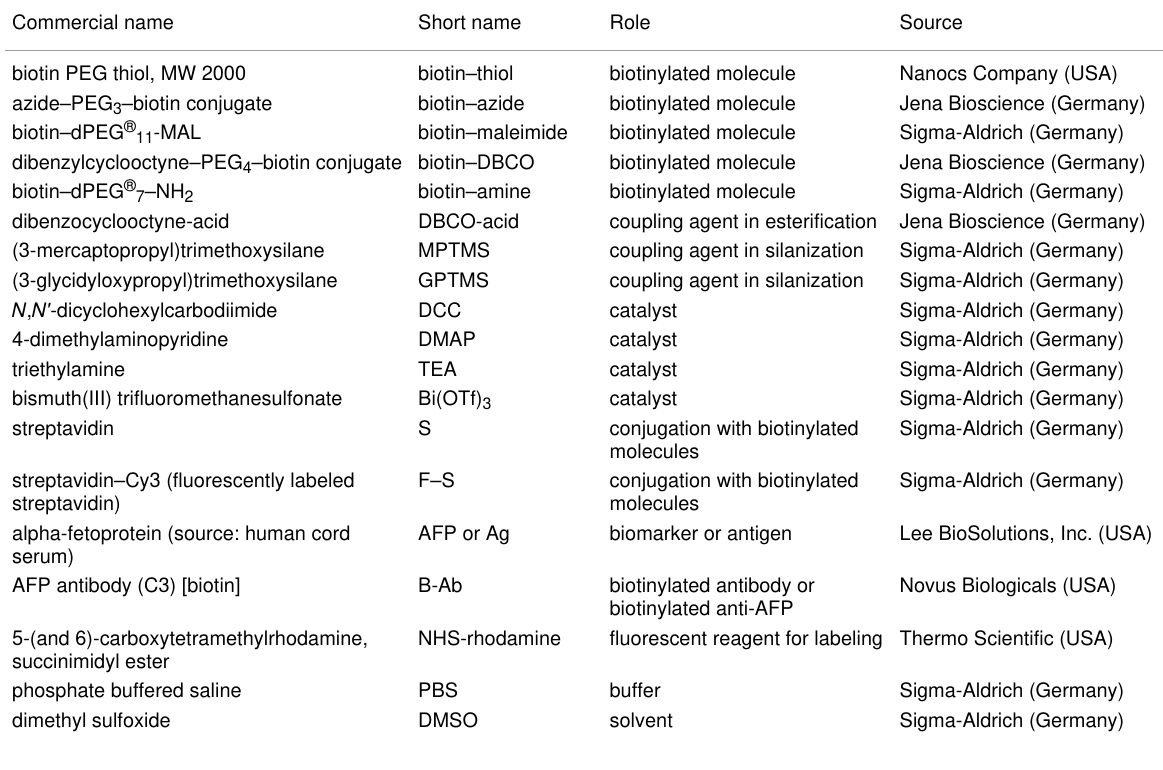
Table 1: Overview of the materials used in the